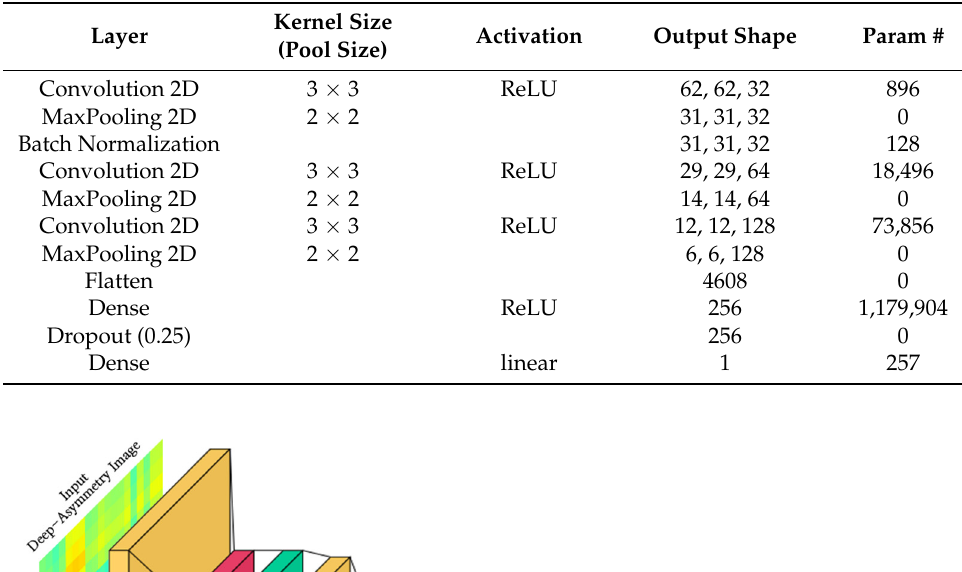
Table 3. Parameters of the deep-asymmetry model.